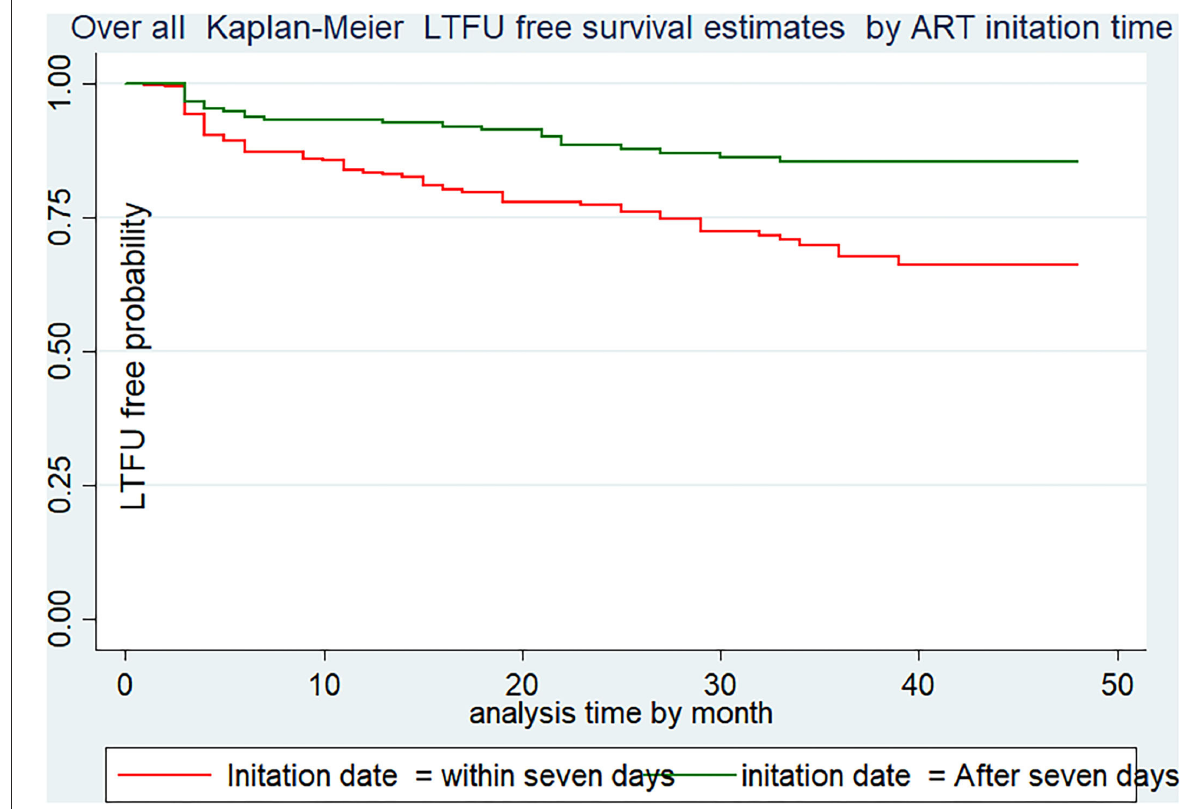
FIGURE3 LTFU-free survival estimates using ART initiation date of Adults receiving in FHCSH, Northwest Ethiopia,